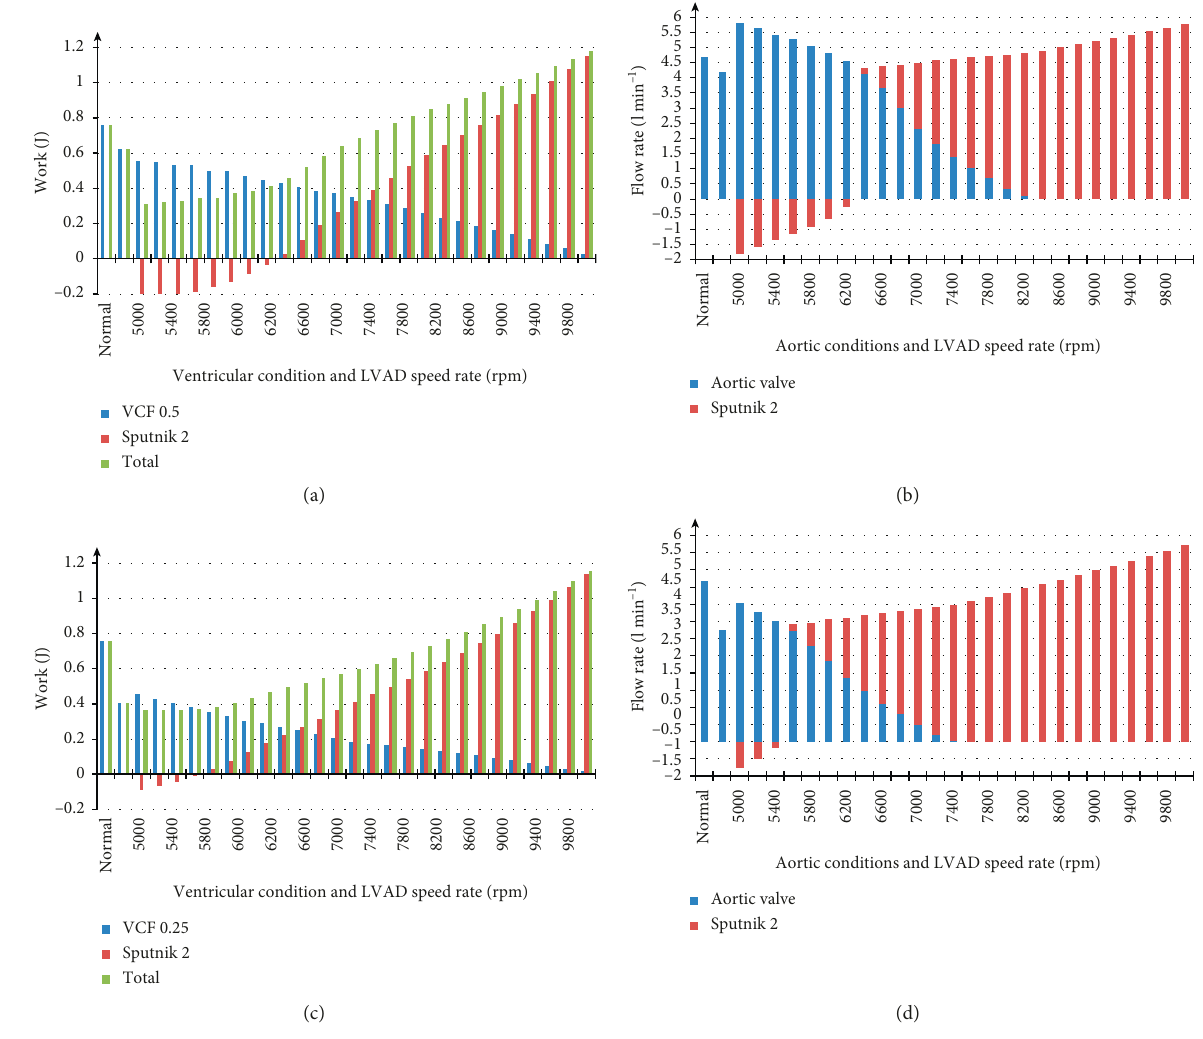
Figure 6: (a, c) Average levels of left ventricular work, hydraulic pump work, and total work during Sputnik 2 LVAD support with ventricle contractility factors (VCFs) of 0.5 and 0.25, respectively, in the pump speed range of 5000–10000rpm with 200 rpm step. (b, d) Average aortic valve and pump flow rates with respect to normal, heart failure, and supported states in the pump speed ranges specified for Sputnik 2 LVAD supporting LV with VCFs of 0.5 and 0.25, respectively. Stroke work and aortic valve flow rates in normal and heart failure states are presented for